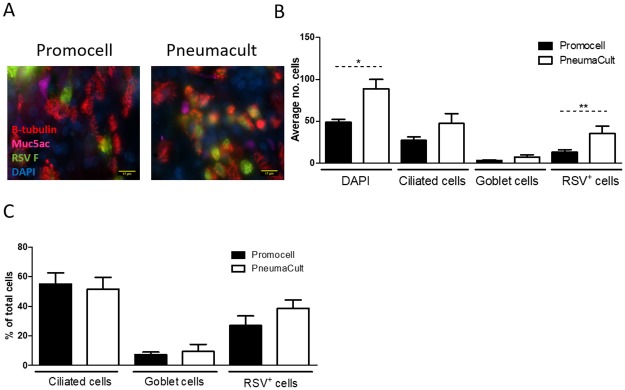
WD-PNEC cultures (n = 3 donors) were differentiated in Promocell or Pneumacult medium.After 21 days cultures were infected with RSV BT2a or mock infected. At 96 hpi the cultures were fixed in 4% paraformaldehyde and stained for β-tubulin, a ciliated cell marker; Muc5ac, a goblet cell marker, RSV F and counterstained for DAPI. Representative images of β-tubulin staining (A). The average number of total, ciliated, goblet and RSV infected cells from 5 fields of view per donor was calculated (B). The percentage of ciliated, goblet and RSV infected cells in the culture was calculated (C). Images were acquired using a Nikon Eclipse 90i at x60 magnification. Statistical significance was determined by t-test.